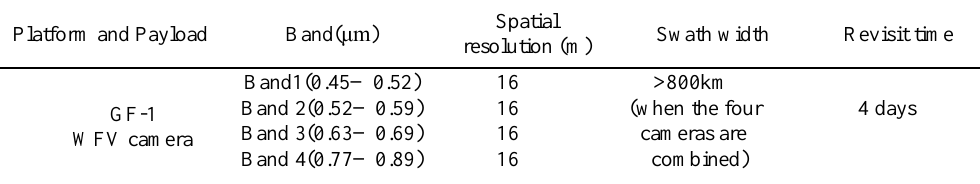
Table 1. Main parameters of GF-1 WFV